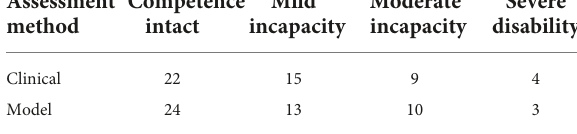
different optimal values on the neural network, as shown in Figure 11 (The X-axis is the epochs parameter and the Y-axis indicates the general